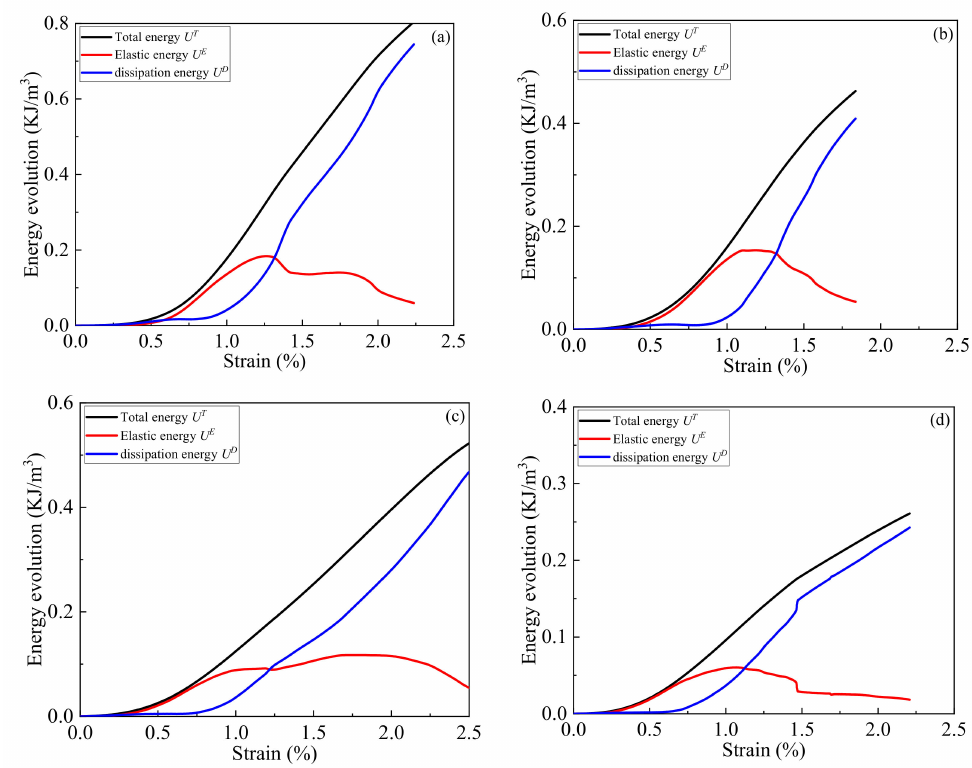
Figure 7. Energy evolution of the different samples: ( a ) RBCM-10; ( b ) RBCM-20; ( c ) RBCM-30; ( d )